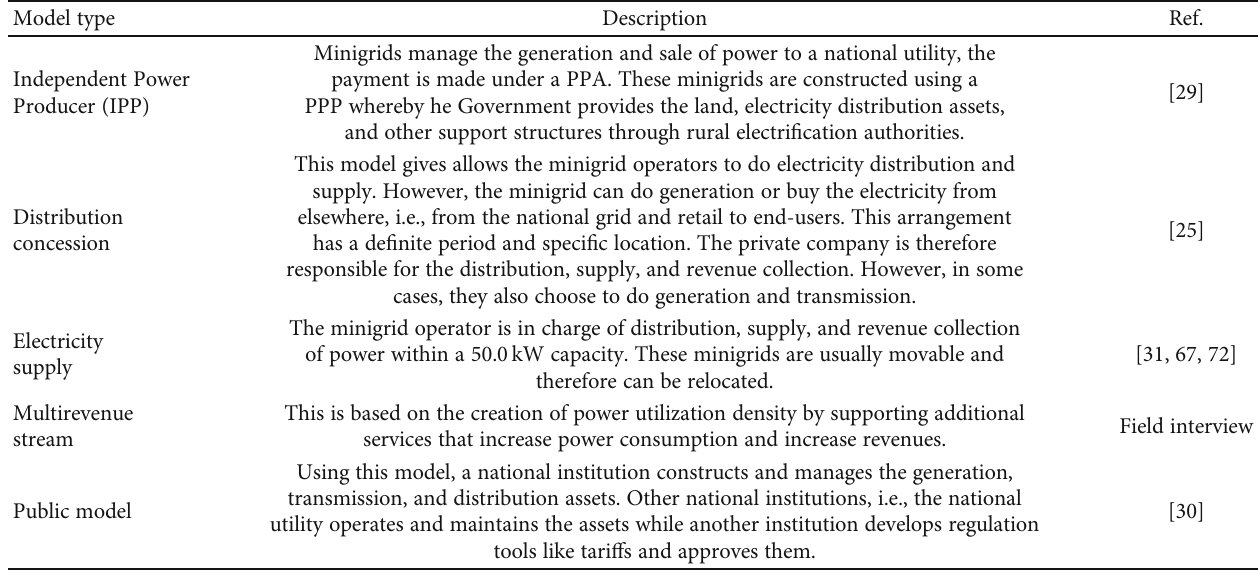
Table 30: Minigrid operation models in East